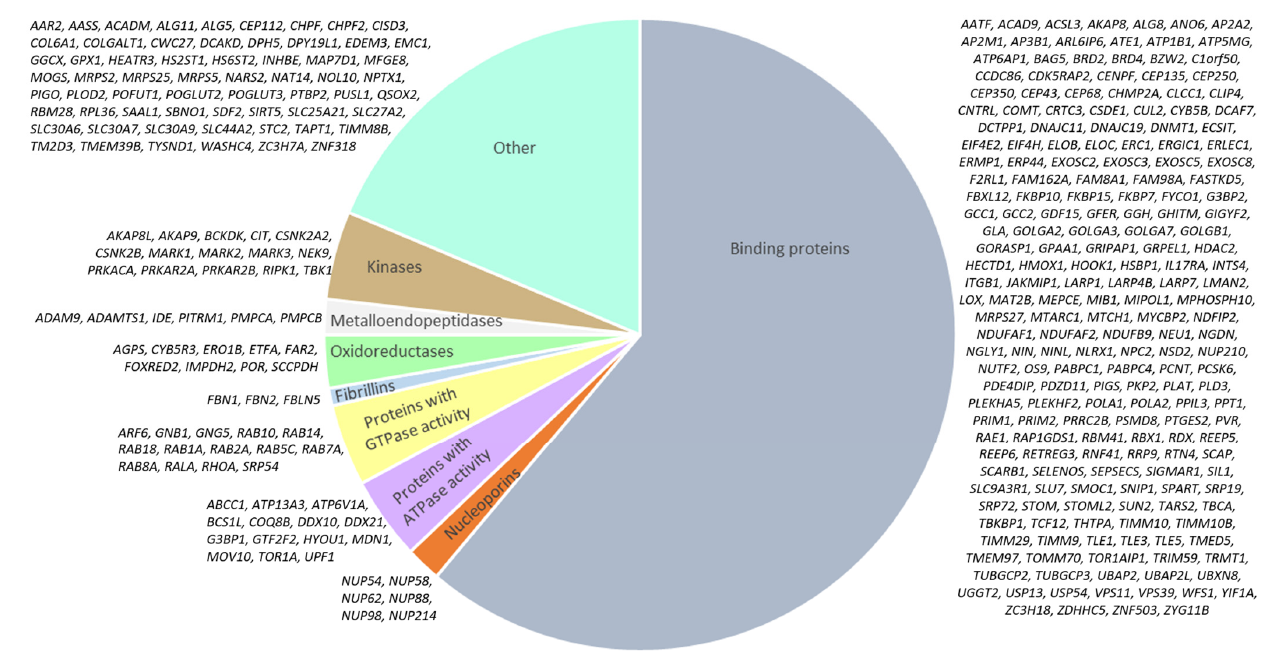
Figure 10. Molecules in the network of human proteins targeted by SARS-CoV-2. As expected, viral process and intracellular transport were identified among enriched GO biological processes in which SARS-CoV-2-targeted proteins participate (Table 10). The list of overrepresented processes included protein transport, folding and heterotrimerization, protein targeting to mitochondrion, tRNA and mRNA transport, regulation of the mitotic cell cycle, regulation of cellular response to heat, and others. In addition, we found the regulation of glucose transport among the overrepresented